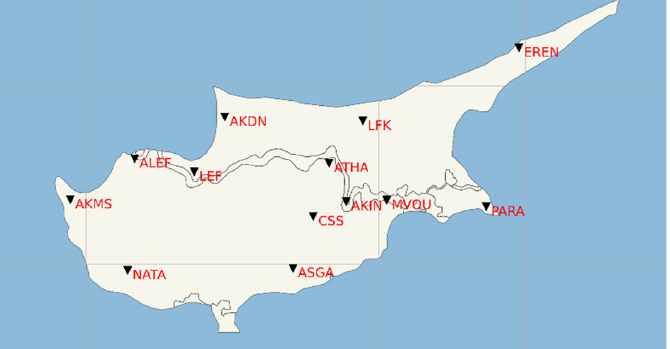
Figure 2. The distribution of 13 seismometers in Cyprus.